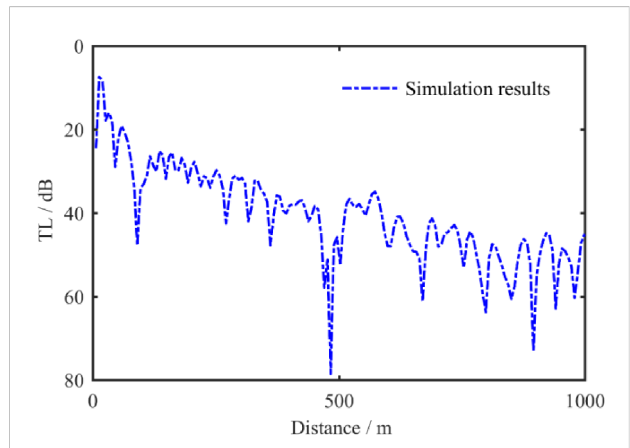
FIGURE 3 TL obtained by using the true value set in the simulation.